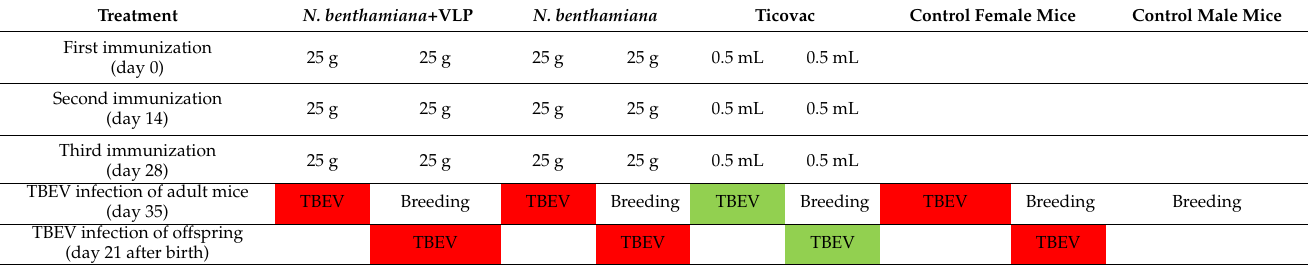
Table 2. Immunization schedule followed by infection with TBEV strain Hochosterwitz in BALB/cAnNRj mice. Mice were housed in groups of five. Female mice (n = 40) were used for immunization and 5 male mice were used for breeding. Mice survived (green) or died (red) post TBEV